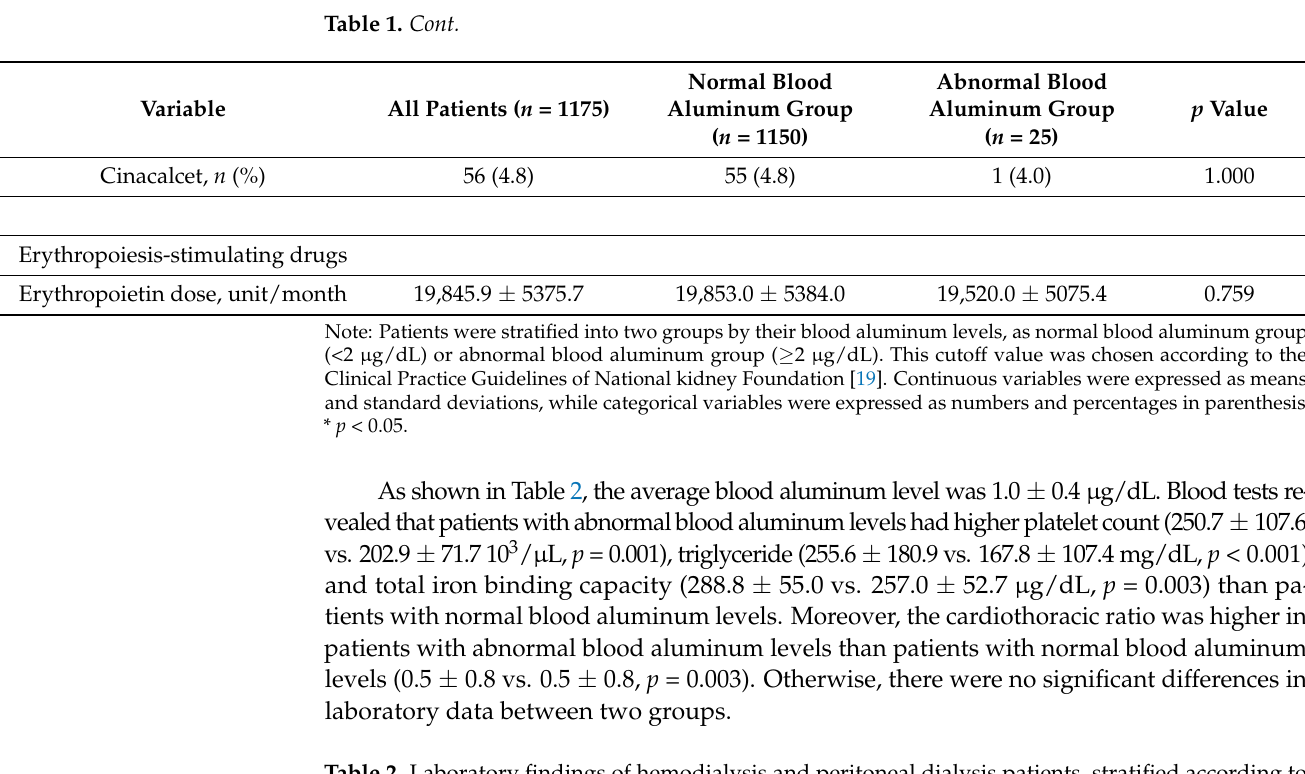
Table 2. Laboratory findings of hemodialysis and peritoneal dialysis patients, stratified according to their blood aluminum levels ( n =